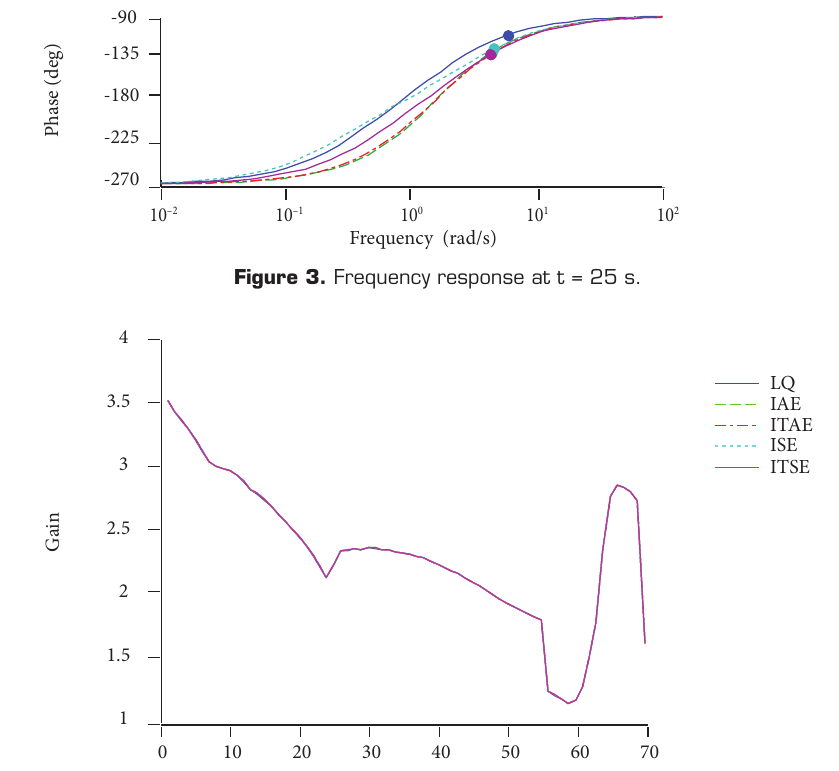
Figure 2. Step response at t = 25